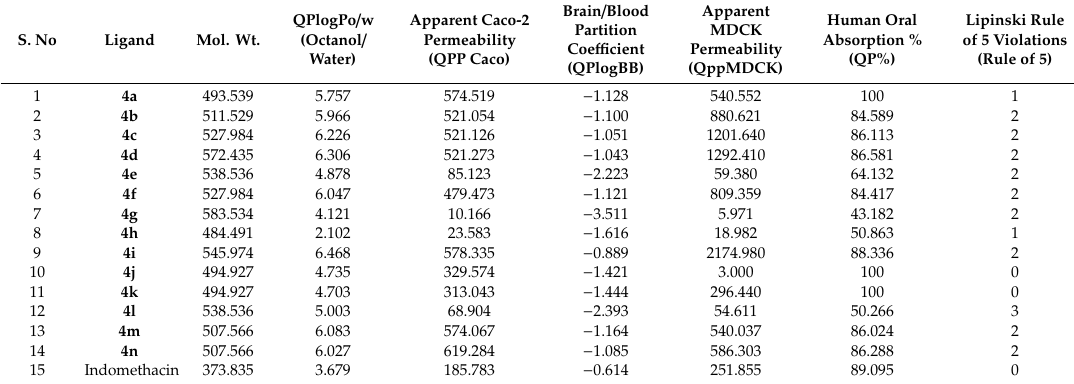
Table 8. Absorption distribution metabolism and excreation (ADME) profiling of all the ligands ( 4a – n ) synthesized to be used as a drug